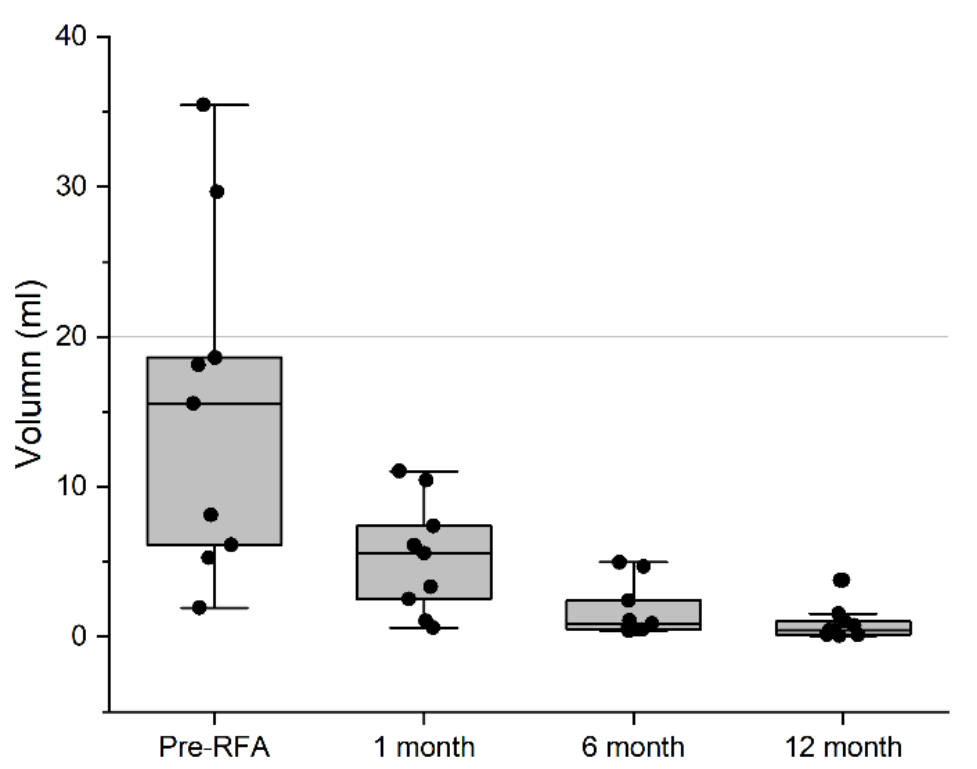
Figure 1. Box plot of Volume Reduction by Time. According to generalized estimating equations, the trend of the decreasing volumes fits a quadratic function ( p = 0.006), and log transformation has a linear regression ( p = 0.003).